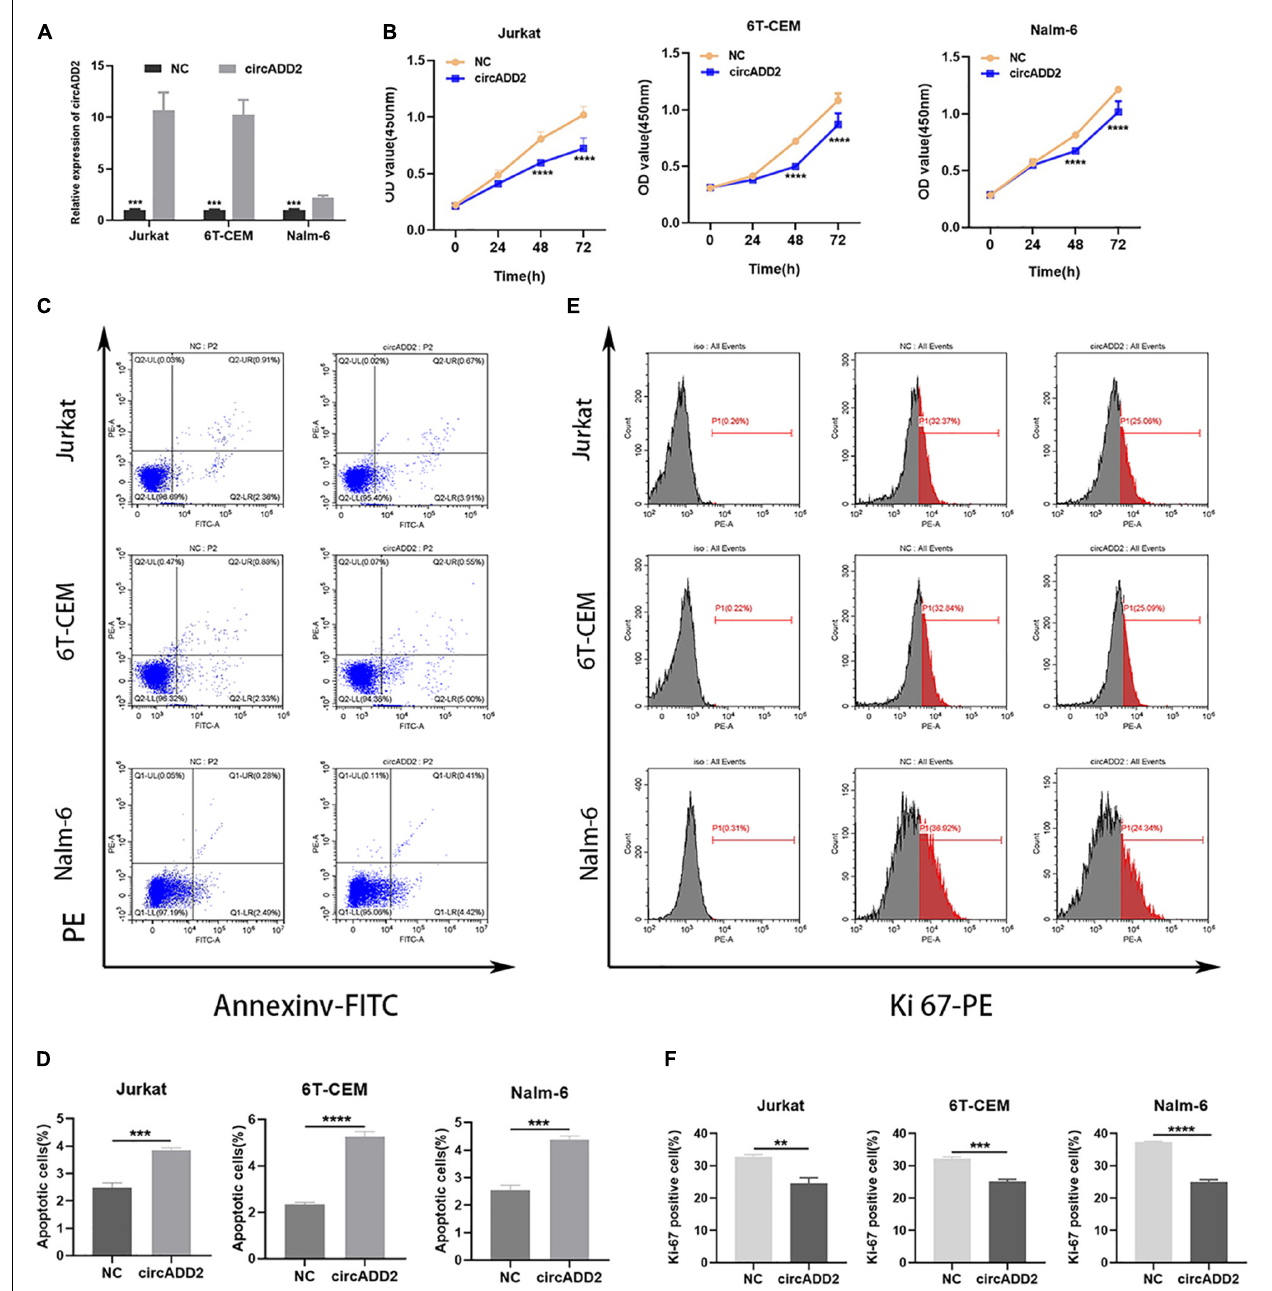
FIGURE 2 | CircADD2 overexpression suppressed ALL progression. (A) Expression of circADD2 was detected in Jurkat, 6T-CEM and Nalm-6 cells transfected with circADD2 overexpression vector and control vector by qRT-PCR. Results indicated successful overexpression of circADD2. (B) CCK-8 assay showed that after circADD2 overexpressing vector was transfected in Jurkat, 6T-CEM and Nalm-6 cells for 48 and 72 h, proliferation of the ALL cells was significantly inhibited. (C,D) Apoptotic rate of Jurkat, 6T-CEM and Nalm-6 cell lines was analyzed by flow cytometry. After overexpression of circADD2, ALL cell apoptotic rate was remarkably increased. (E,F) The ratio of Ki-67 in Jurkat, 6T-CEM and Nalm-6 cells was detected by flow cytometry. The level of Ki-67 positive cells was significantly reduced after overexpression of circADD2. Data were showed as mean ± SD and analyzed by unpaired t -test, ** P < 0.01, *** P < 0.001, **** p <